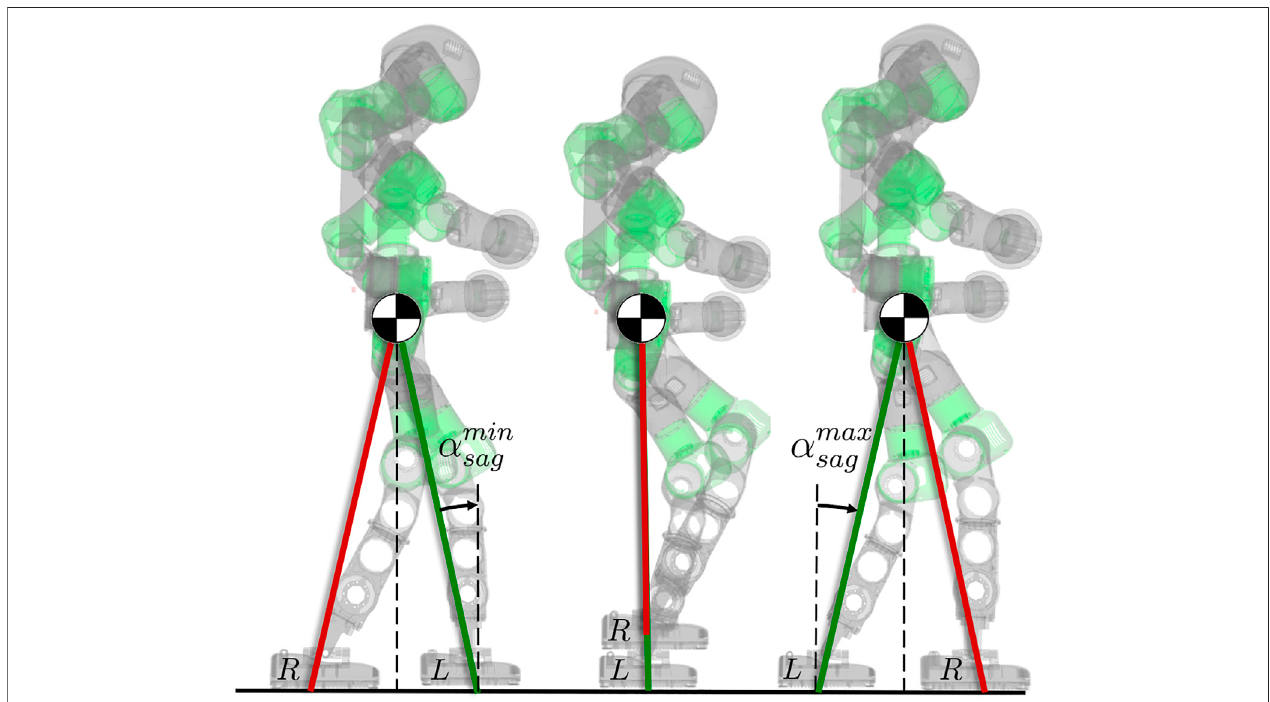
FIGURE2 | Evolution ofone stepping cycle ofthe right leg from taking off tolanding. The2-link compass model isused as atemplate toimpose the desired VC on the robot. The phase variable α sag increases from α min sag to α max sag and constrains the movement of the CoM and the swing foot in the sagittal direction. The VC always constrains the swing leg to mirror the stance